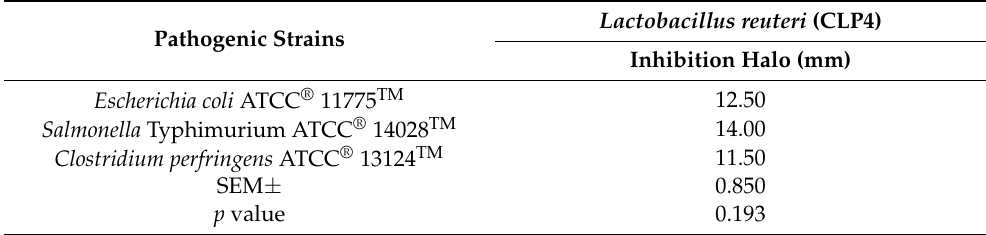
Table 3. In vitro screening of antibacterial activity of CLP4 isolates from the cecal content of Creole roosters against enteropathogenic bacteria ( n = 6).